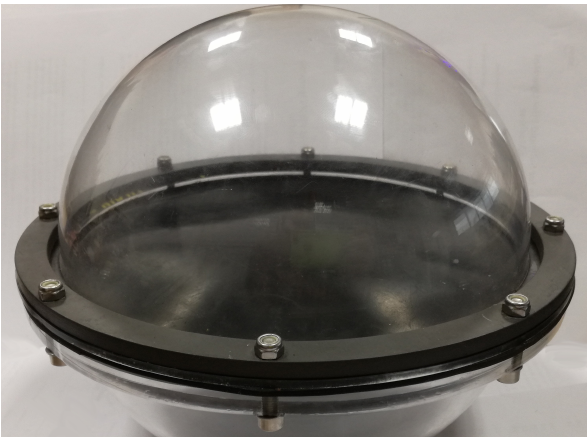
Figure 12. Example of two joined domes before testing.